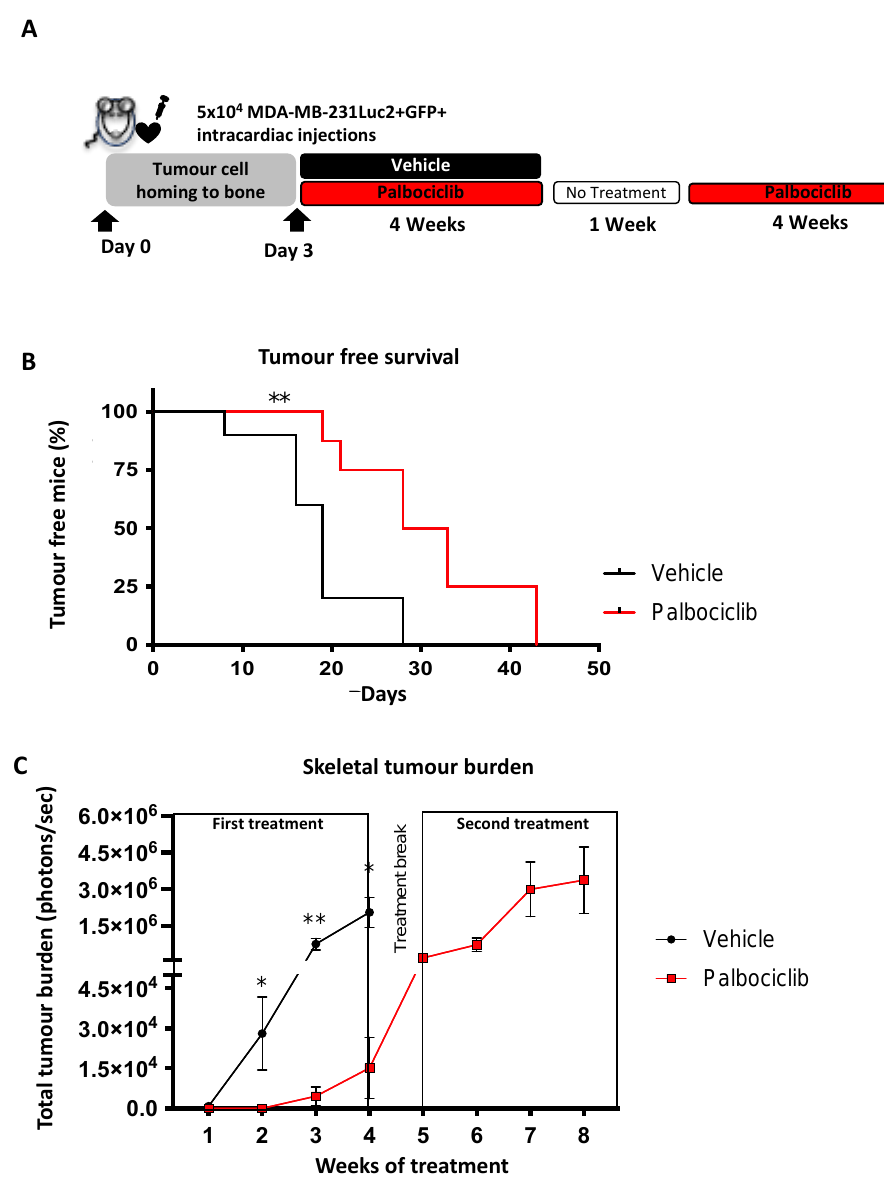
Figure 5. Palbociclib fails to inhibit tumour growth in bone following a break in treatment. ( A ) Schematic outline of the experiment. Mice were injected with 5 × 10 4 MDA-MB-231Luc2+GFP+ cells via the intracardiac route. Treatment with 100 mg/kg palbociclib or vehicle commenced on day 3 and continued for 28 consecutive days, followed by a 7-day break before a second cycle of daily palbociclib treatment commenced. ( B ) Percentage of tumour positive mice ( n = 8 per group, ** p < 0.005; Log-rank (Mantel–Cox) test vehicle vs palbociclib) and ( C ) mean (± SEM) tumour burden in each treatment arm ( n = 8 per group, * p < 0.05; multiple t -test).